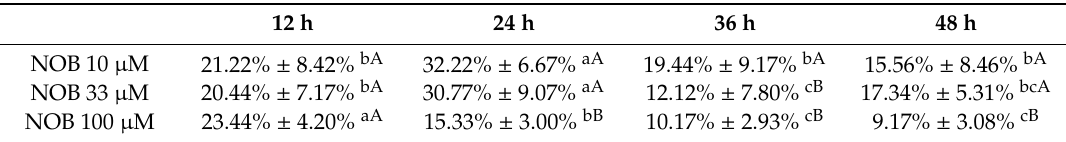
Table 1. Cellular uptake of NOB.